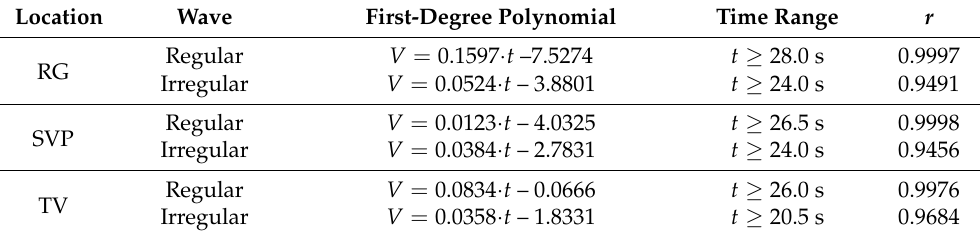
Table 3. Statistical parameters of curve fitting.